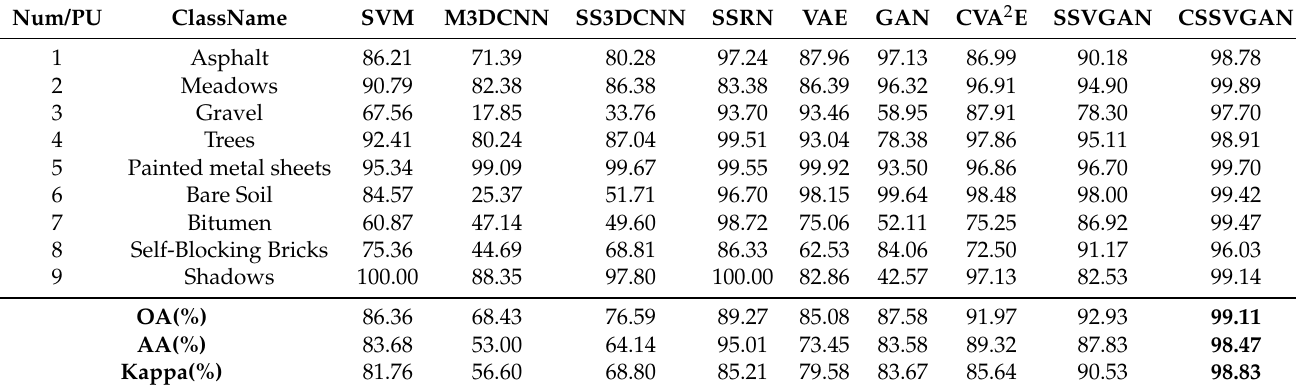
Table 10. The classification results for the PU dataset with 1% training